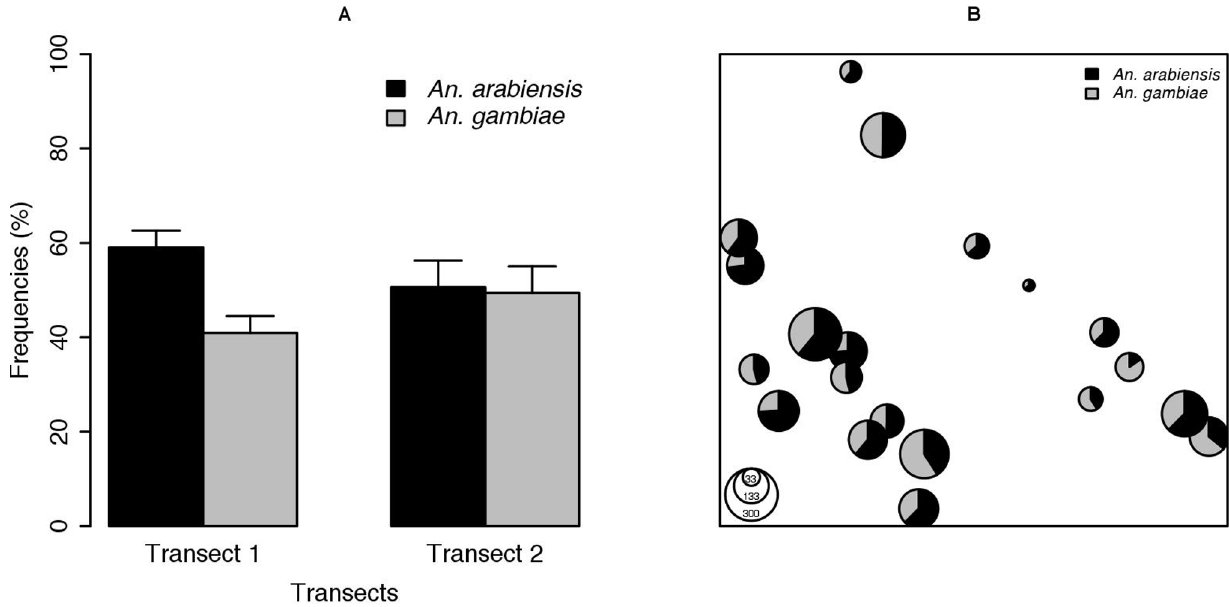
Figure 2. Variations of the mean frequencies of An . arabiensis and An . gambiae . A: between transects, bars represent standard errors. B: within villages in each transect (Transect 1=T1, Transect 2=T2).